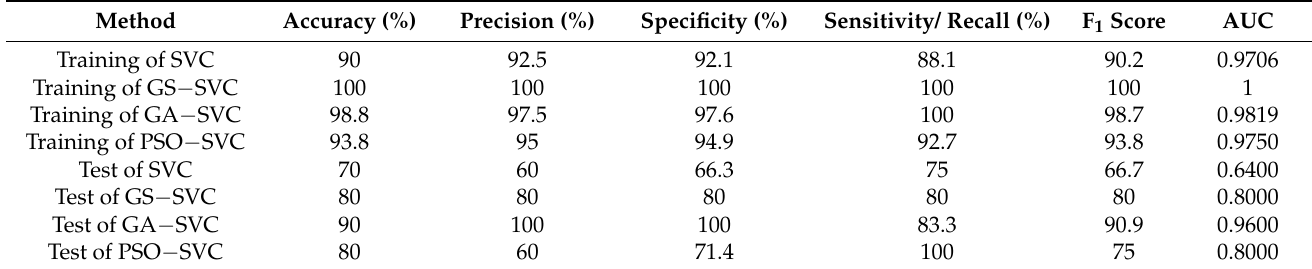
Table 1. Classification metrics of SVC, GS − SVC, GA − SVC, and PSO − SVC models.